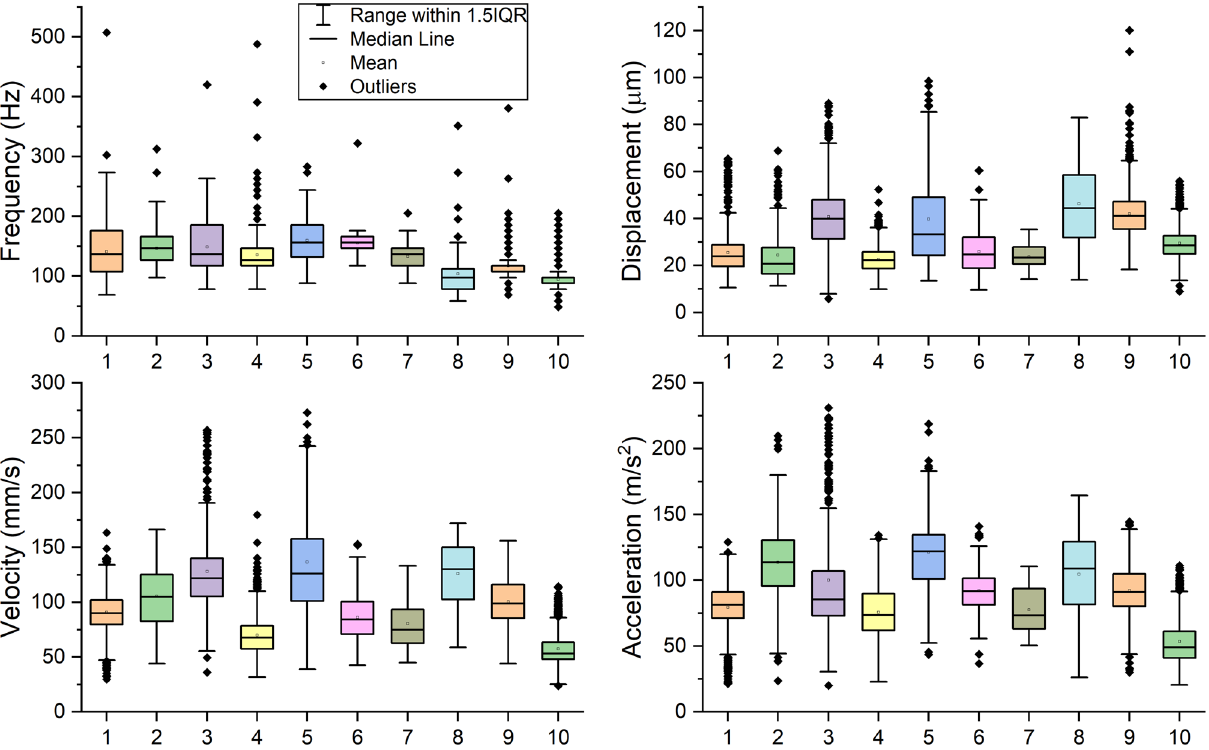
Figure 4. Thorax kinematics (frequency, peak displacement, velocity, acceleration) over all intervals for all carpenter bee individuals (1–10 on the x-axis). Individuals 1–5 were tested on the plastic post, and individuals 6–10 were tested on the carbon fiber post. Individuals 1–10 had 711, 244, 390, 1336, 136, 379, 35, 100, 693 and 1122 measurement intervals,